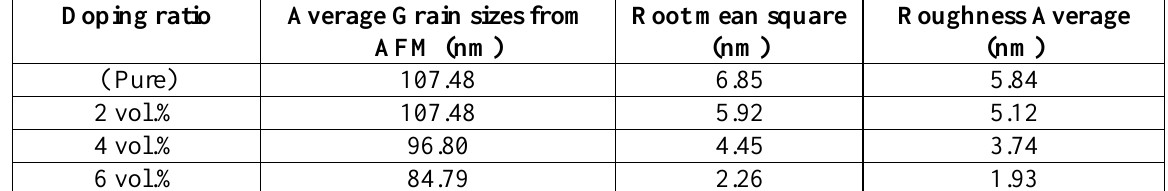
Table 2: The average grain sizes and roughness average for CdO prepared on silicon